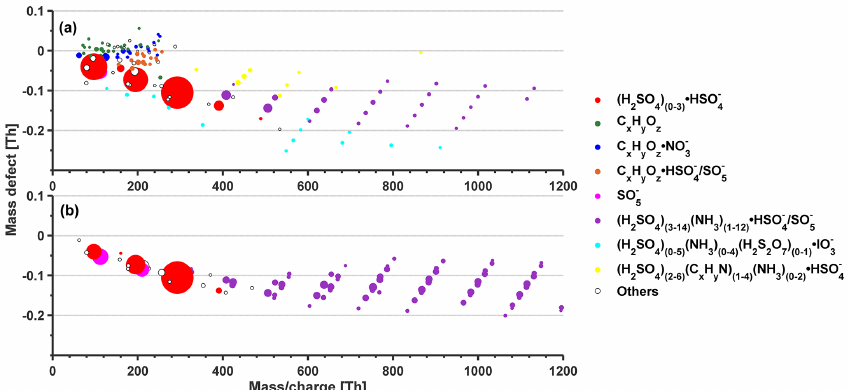
Figure 11. Comparison of ambient and laboratory measurements. (a) Mass defect plot from the Jungfraujoch on 12 November 2013 from 08:30 to 12:30LST. (b) Mass defect plot from a laboratory experiment at the CLOUD chamber involving H 2 SO 4 and NH 3 clusters (adapted from Schobesberger et al.,